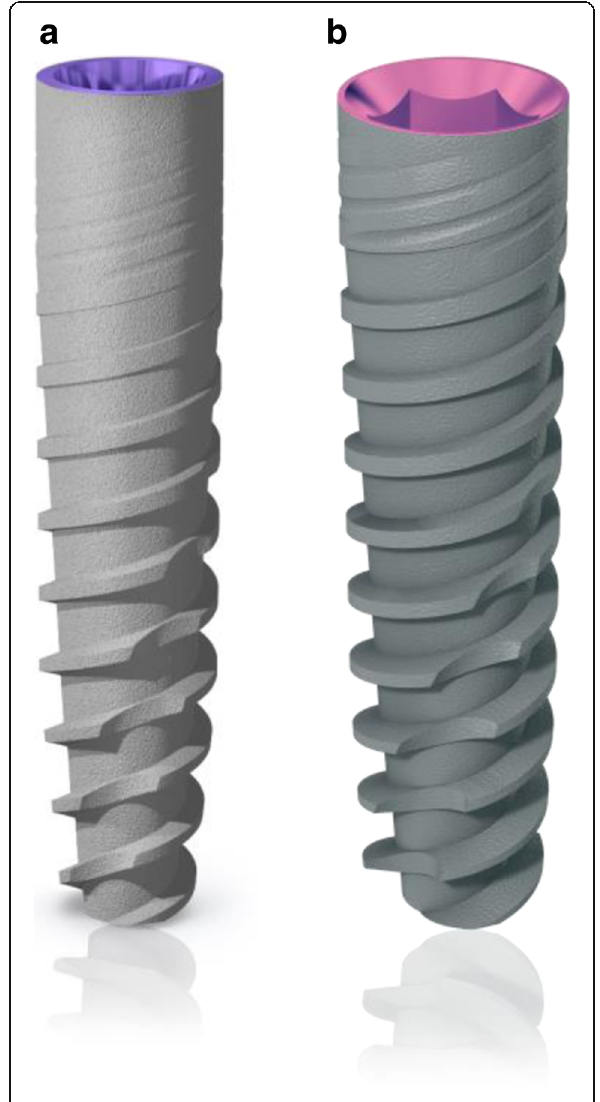
Fig. 1 Characteristics of the implants used in the study: a external macro-design of JDIcon Ultra S, 2.75 mm diameter implant and b external macro-design of JDEvolution S, 3.25 mm diameter